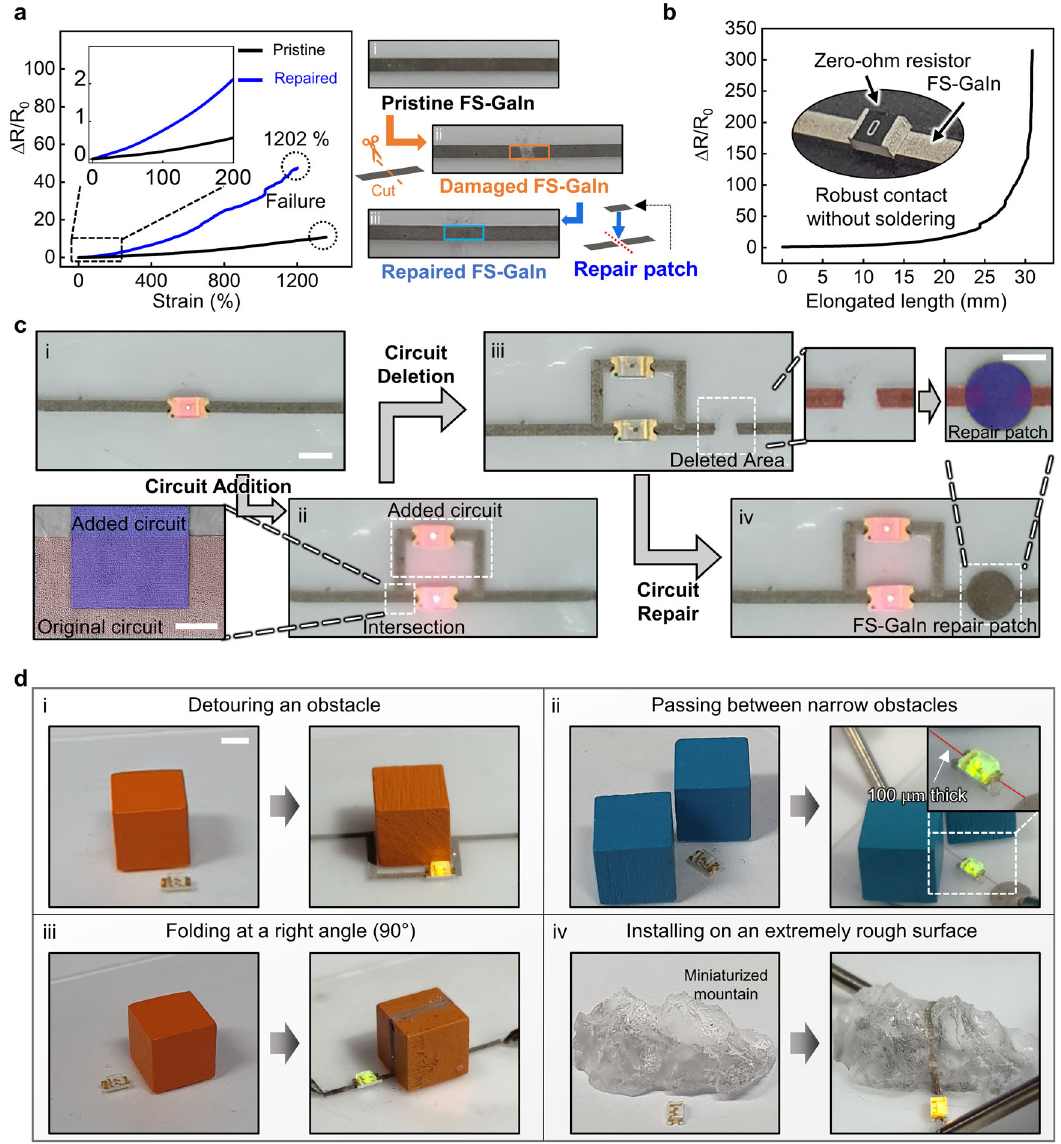
Fig. 4 Applications of FS-GaIn. a Electromechanical behavior of the pristine and repaired FS-GaIn circuit. (i) The pristine FS-GaIn, (ii) The deliberately damaged FS-GaIn. (iii) The repaired circuit by the FS-GaIn repair patch. b Relative change in resistance as a function of the uniaxial tensile strain (0.5 mm s − 1 ) of the FS-GaIn trace with a zero-ohm resistor. Inset: the digital image of the FS-GaIn with a zero-ohm resistor. c Demonstration of the in situ circuit modi fi cation with FS-GaIn. (i) A circuit with LED on. (ii) In situ circuit addition by placing a new FS-GaIn circuit with another LED. Inset: the SEM image of the original circuit (red pseudo-color) and the newly added circuit (blue pseudo-color) (iii) A disconnected circuit with LEDs off. Inset: the digital image of the damaged area (red pseudo-color). (iv) Repaired circuit with the FS-GaIn repair patch indicated by two bright LEDs. Inset: the digital image of the original circuit (red pseudo-color) and the newly added repair patch (blue pseudo-color). d FS-GaIn ’ s utility in various constrained situations: ( a ) detouring an obstacle, ( b ) passing between narrow obstacles, ( c ) folding at a right angle (90°), and ( d ) installing on an extremely rough surface of a miniaturized mountain. Scale bars: 3 mm ( c , d ), 300 μ m ( c left inset), 2 mm ( c right AgNW. A circuit repaired by applying an FS-GaIn patch also demonstrates stable contact and the ability to withstand over 1000% strain without electrical disconnection. The facile fabrica- tion method of FS-GaIn using a combination of direct laser writing and etching enables the rapid fabrication of appropriately patterned FS-GaIn in maskless and room temperature condition. The fabrication of FS-GaIn is realized by fully utilizing the differentiated etching behavior between multiphase sintered region and not sintered region. The features of FS-GaIn also make it possible to perform in situ circuit modi fi cation, attachment to